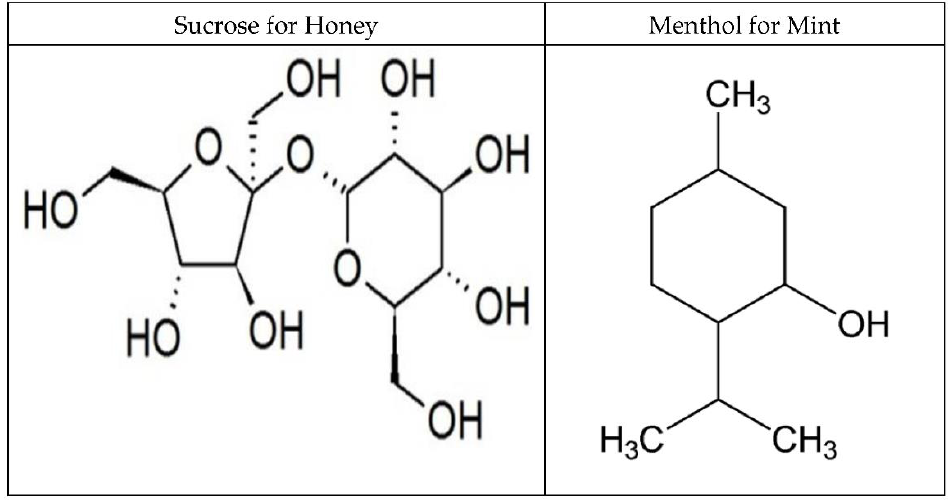
Figure 1. Molecular structures of the main ingredients of honey and mint as the inhibitors employed in the experiment. in the